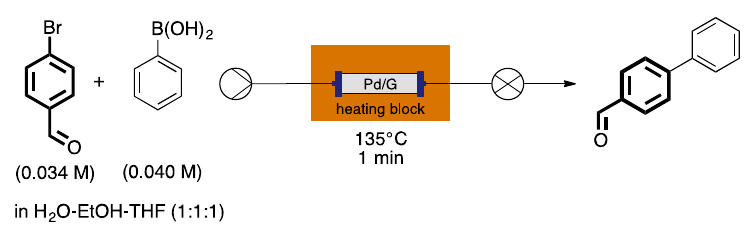
Figure 3. Substrate scope of continuous flow Suzuki–Miyaura cross-coupling sequence in a flow system using H-Cube ® .